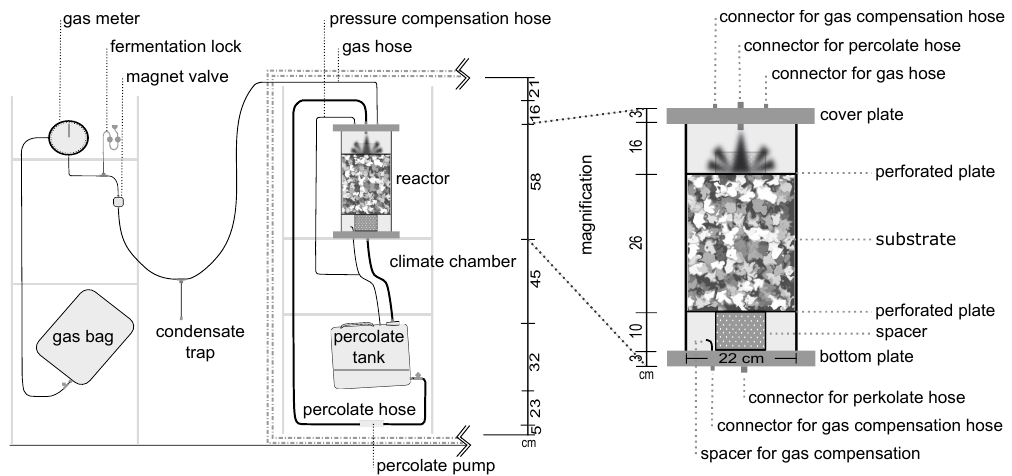
Figure 4. Scheme of the test setup for one reactor including gas collection and